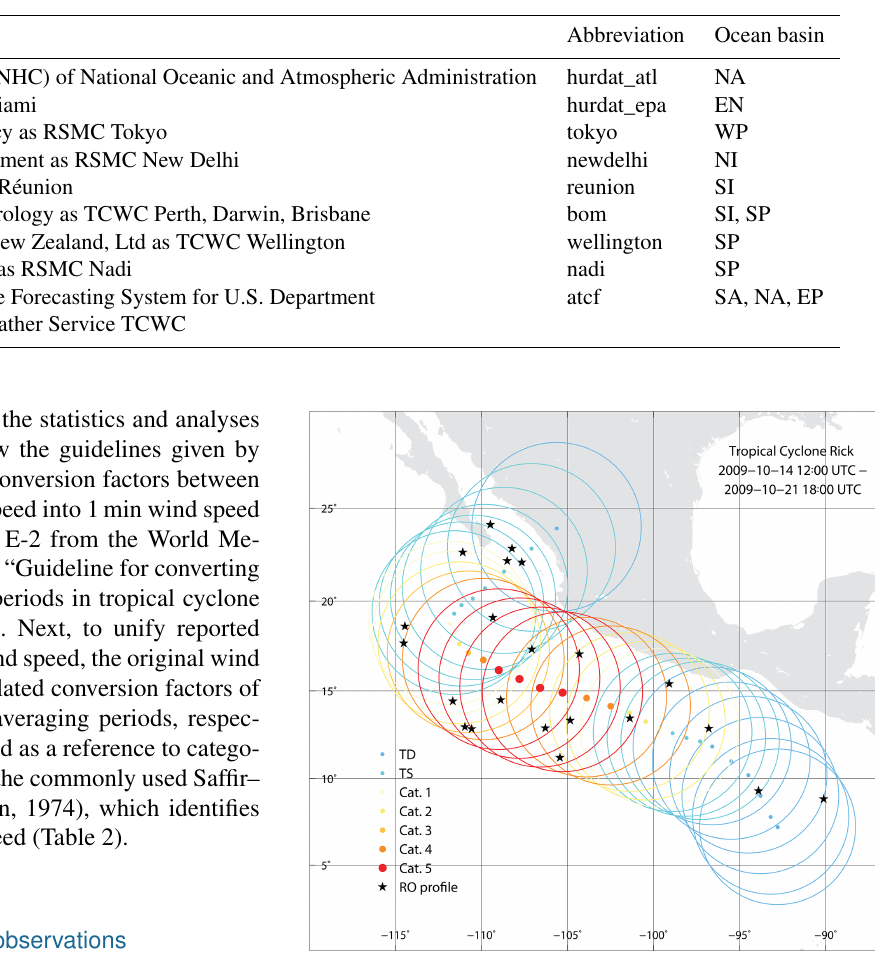
Figure 1. An example of co-location of TC with RO profiles (black stars) based on Hurricane Rick developed between 14 and 21 Octo- ber 2009. Dots present the TC eye position, whilst circles mark the 500km co-location criterion. Colours indicate the intensity of